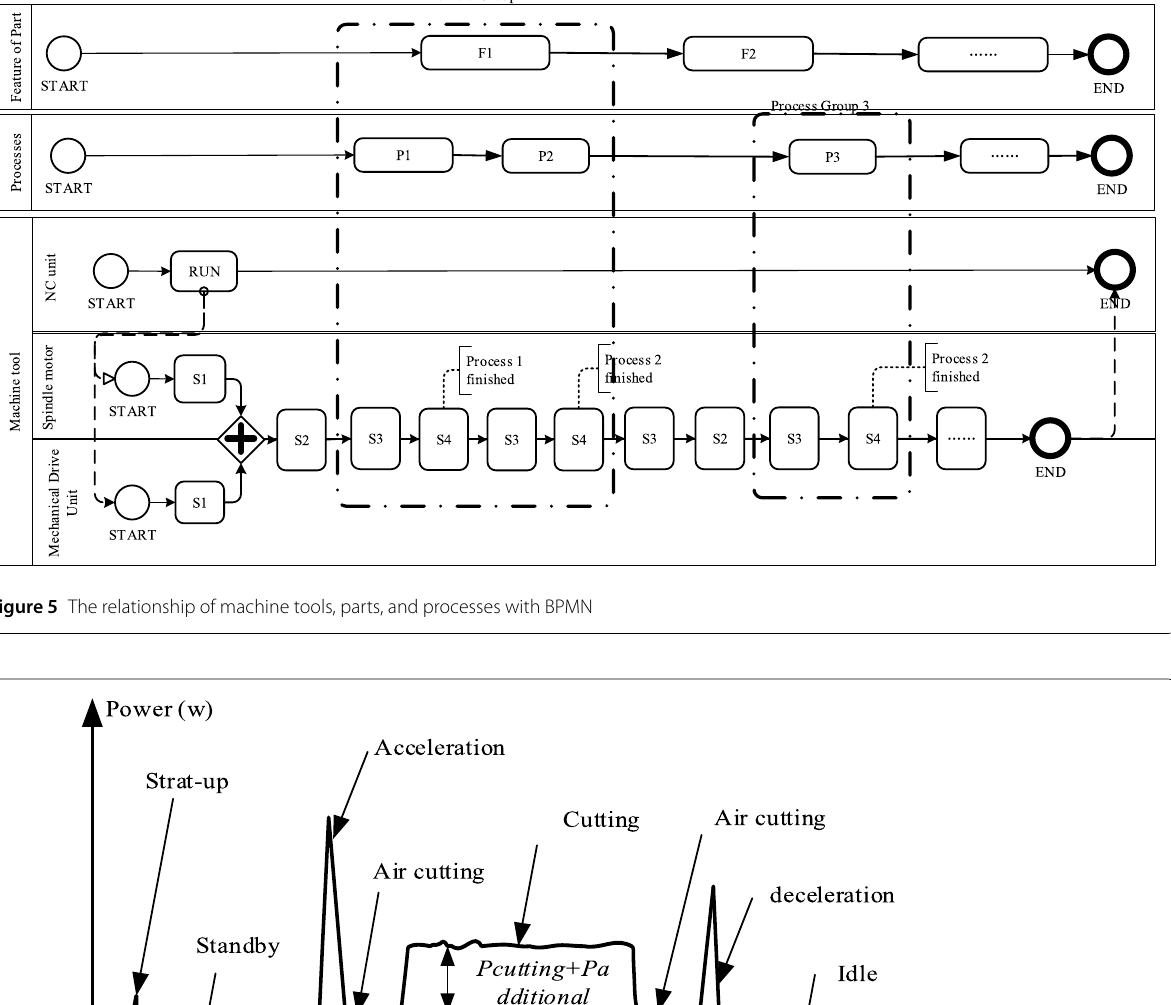
Figure 6 Power curve of a machine tool